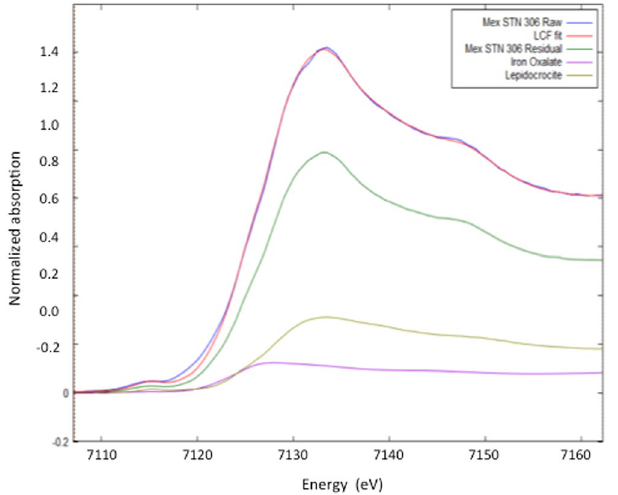
Figure 1. Iron K-edge XANES Linear Combination Fitting of the raw sediment Fe spectra for the Mexican 306 sediment using three end-members: goethite/lepidocrocite, ferric oxalate and the reactive iron extracted sediment residue. The best fit (red trace) is almost superimposed on the spectra for the raw, untreated sediment (blue trace).